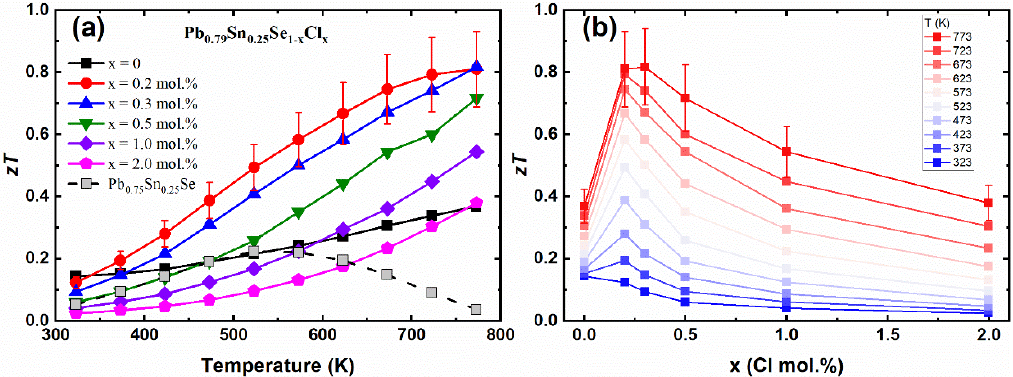
Figure 6. ( a ) Temperature-dependent zT values; ( b ) The zT values for the various temperatures, as indicated, with the Cl-doping concentration of the Pb 0.79 Sn 0.25 Se 1 − x Cl x (x = 0.0, 0.2, 0.3, 0.5, 1.0, 2.0 mol.%) and Pb 0.75 Sn 0.25 Se compounds.